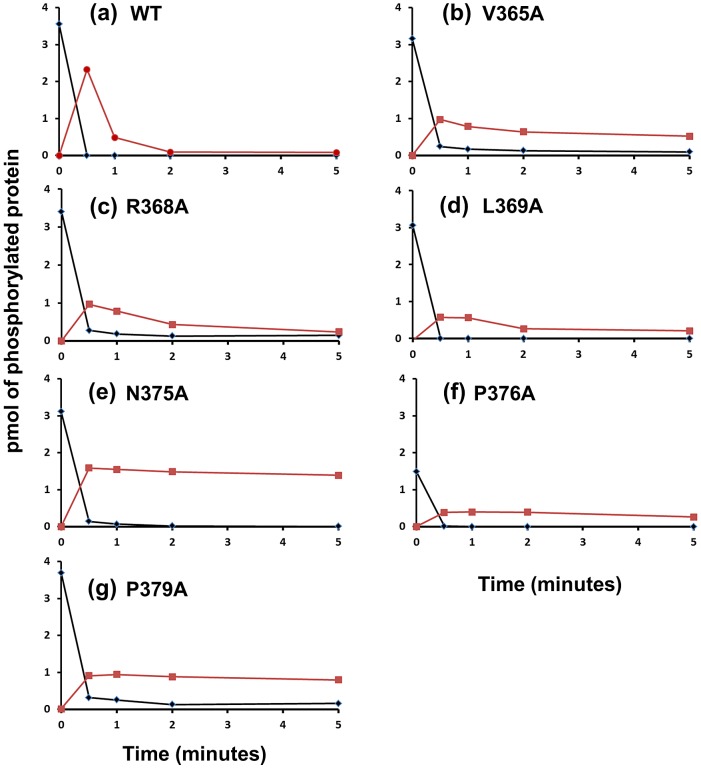
Phosphotransfer Assays with Phosphatase Mutants.CrdS-WT or mutant proteins displaying reduced CrdA∼P phosphatase activity were tested for phosphotransfer capacity. CrdS proteins were allowed to reach maximal phosphorylation and then mixed with equimolar amounts of CrdA. Samples were collected at 0, 0.5, 1, 2, and 5 minutes and resolved by electrophoresis, imaged and quantified. Results indicate pmol of phosphorylated proteins (y-axis) for (▪) CrdA∼P and (♦) CrdS∼P over time (x-axis). (A) WT CrdS (B) V365A (C) R368A (D) L369A (E) N375A (F) P376A (G) P379A.